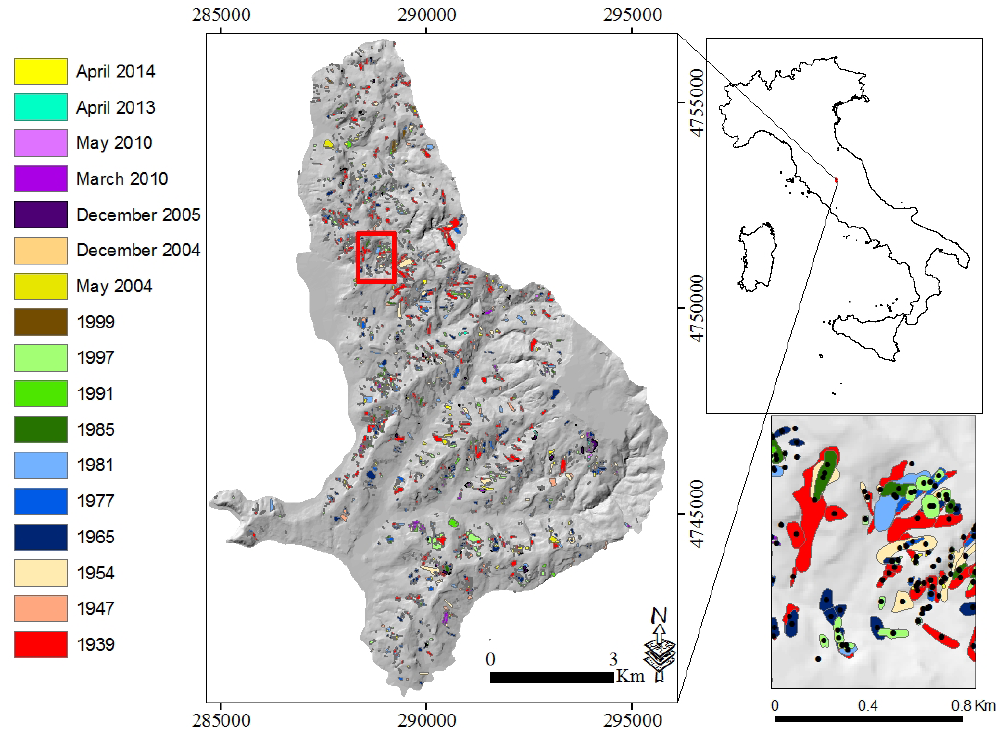
Figure 1. Multi-temporal landslide inventory dating from 1939 to 2014 (left map; adapted from Samia et al., 2017a, b, 2018). Collazzone study area and Umbria region (right upper map). The coordinate system of maps is EPSG:32633 (https://www.spatialreference.org/). Land- slide points were constructed by placing a point in the geometric centre of each landslide polygon (map in the right lower corner). The red rectangle shows the extent of the map in the lower